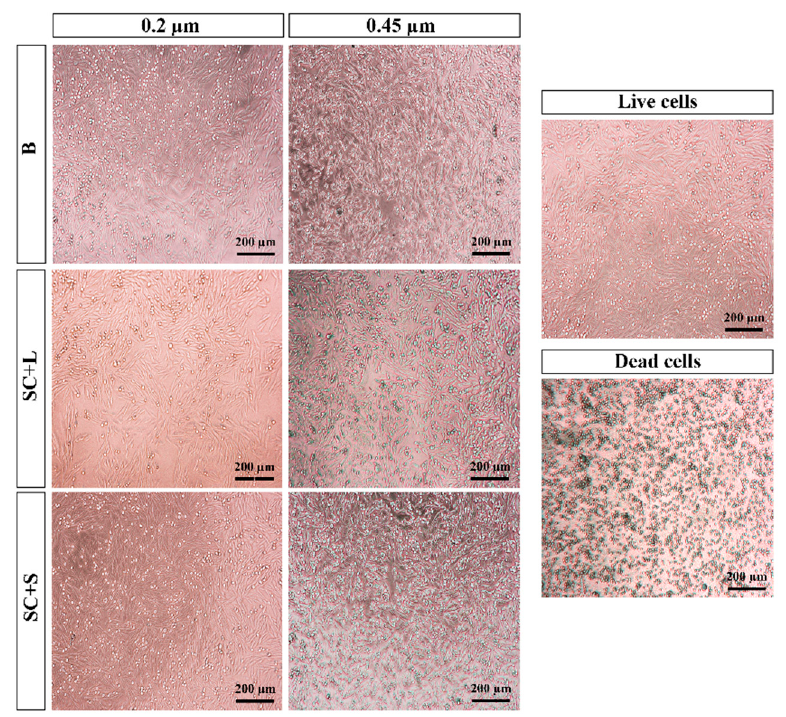
Figure 2. Microscopic images of cell cultures in the presence of liposomes (B: blank liposomes without additive; SC: sildenafil citrate liposomes without additive; SC + L: sildenafil citrate liposomes with lactose; SC + S: sildenafil citrate liposomes with sucrose). In the positive control (K+), with cell death induced by the addition of ethanol, neither adhesion nor proliferation was observed; however, a spherical shape typical of dead cells was observed. The results of the MTT assay (Figure 3) show that B and SC liposome samples, as well as SC + L and SC + S, did not produce cytotoxic effects. After confirming that the Dh, PDI, and zeta potential values of C liposomes were not statistically different from those of SC liposomes, a cell uptake and internalization assay was performed on C liposomes with and without additive.